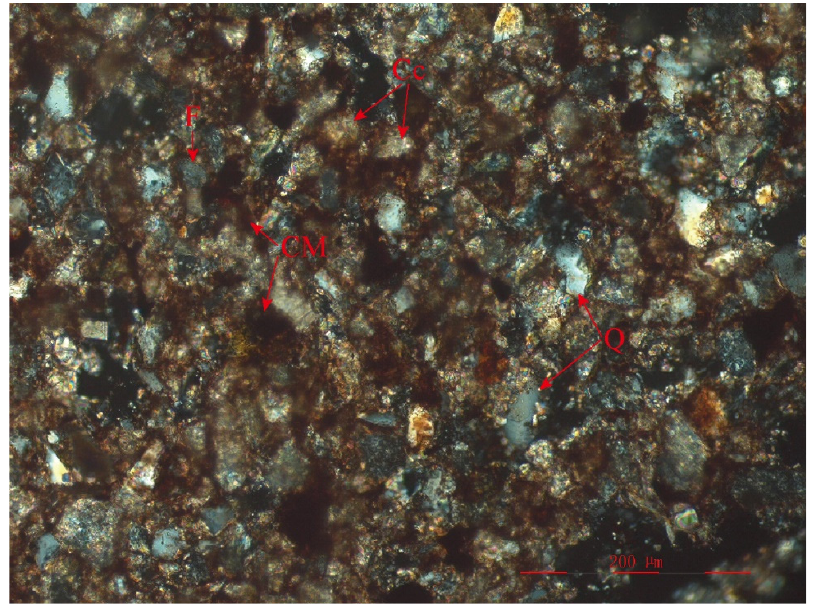
Figure 1. Photomicrographs of the tested specimen. Legends: Q stands for quartz, CM for clay mineral, Cc for calcite, F for feldspar.